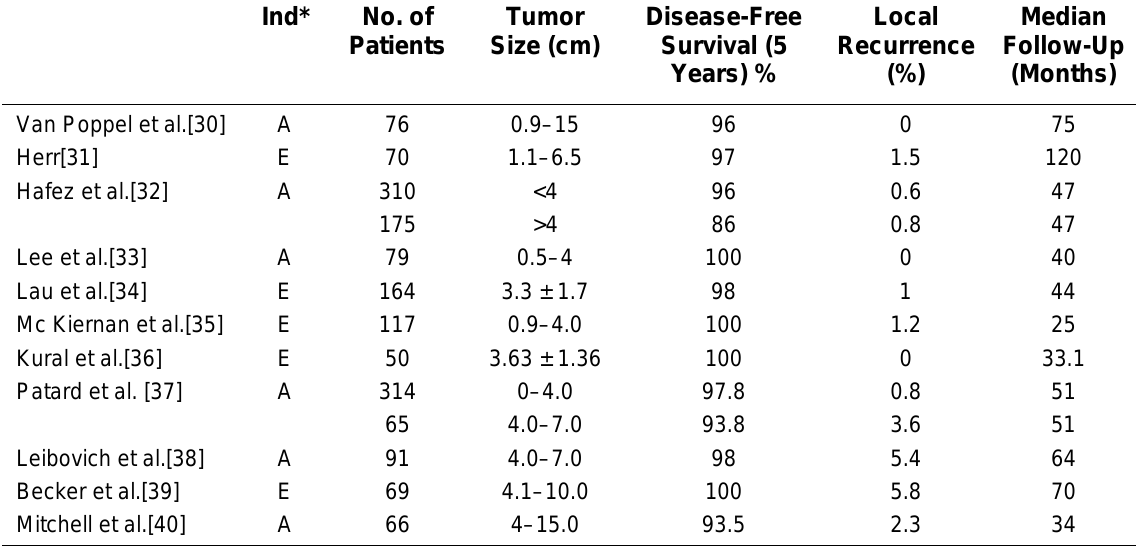
Ind* No. of Patients